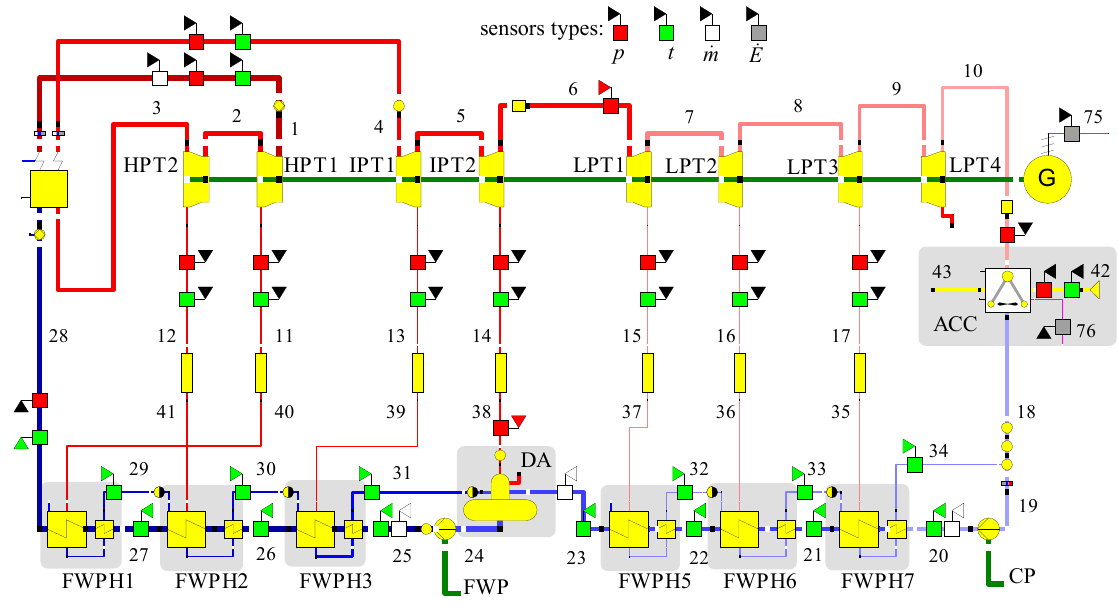
Figure 3. The flowsheet of the turbine subsystem investigated.